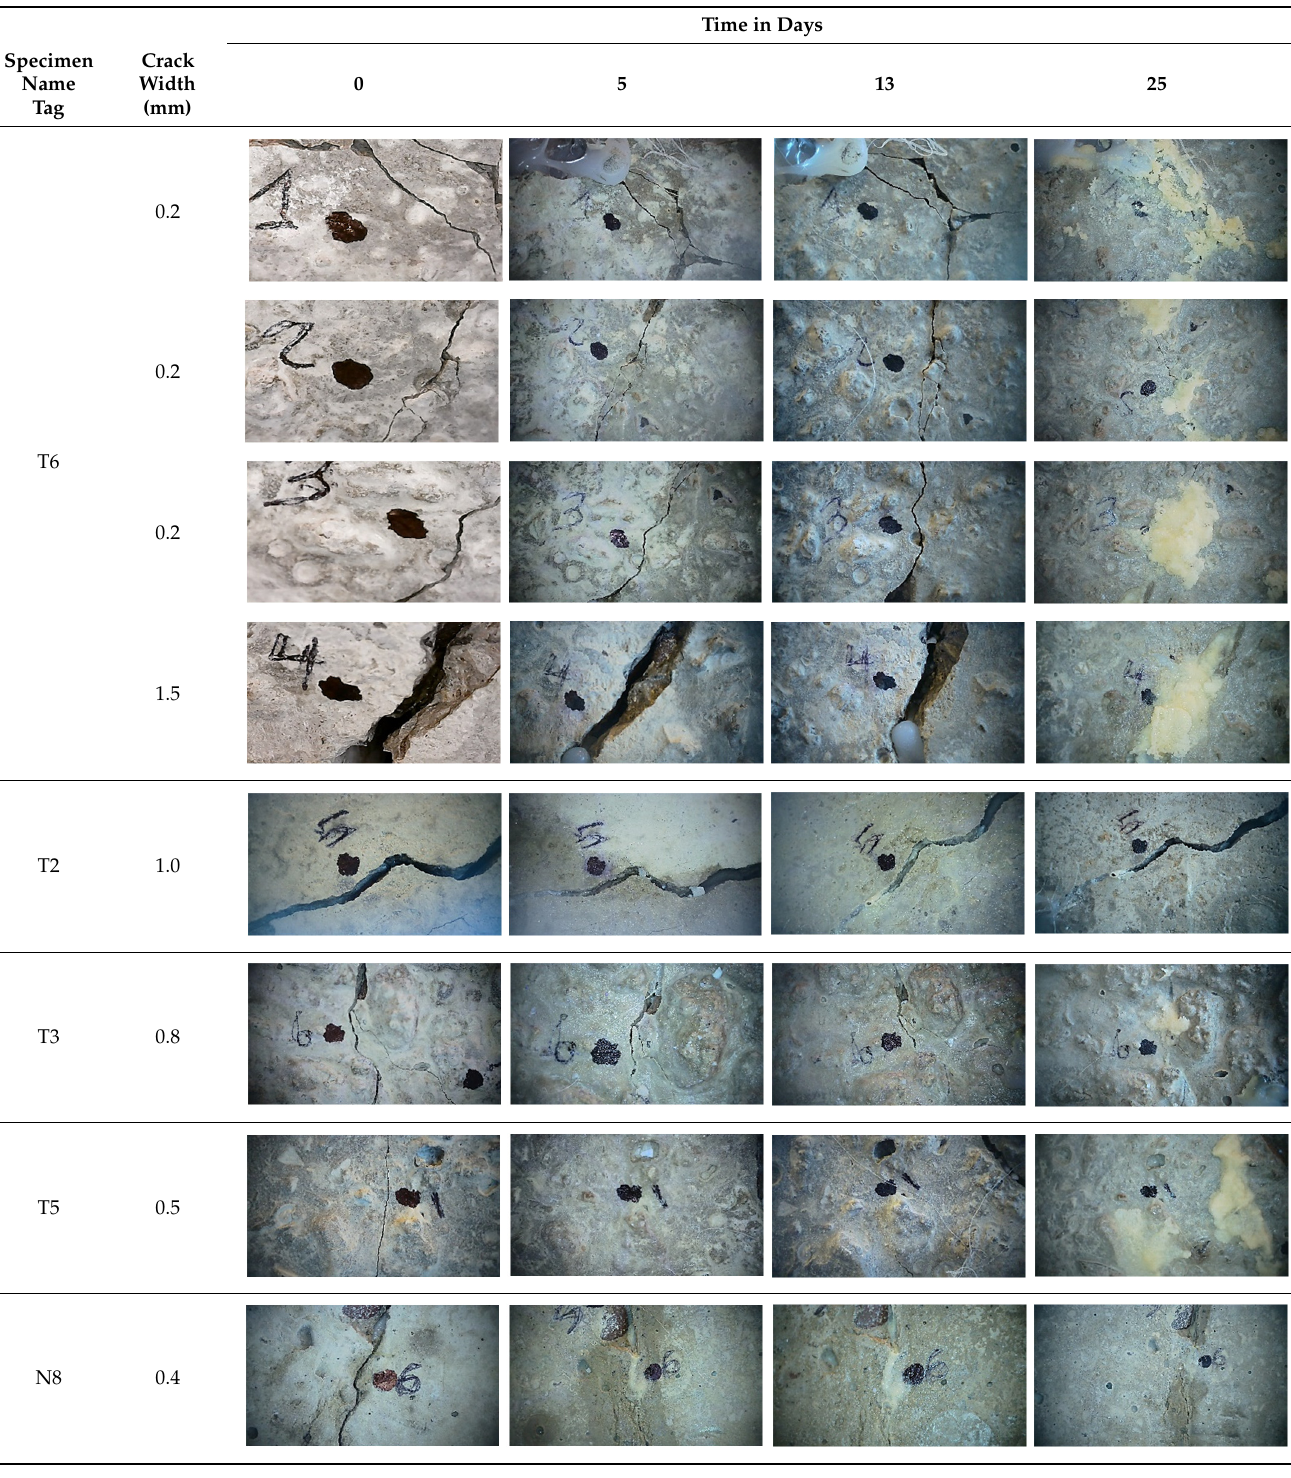
Table 14. Image compilation for self-healing evaluation for extrinsic approach. Time in Days